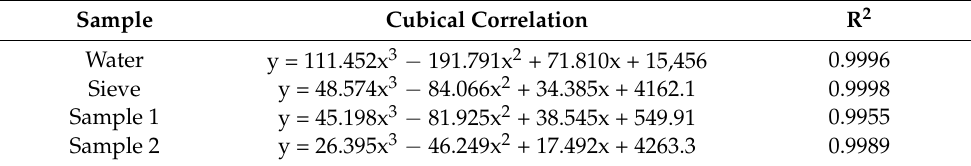
Table 2. Samples’ water vapour permeability (y) as a function of pressure gradient